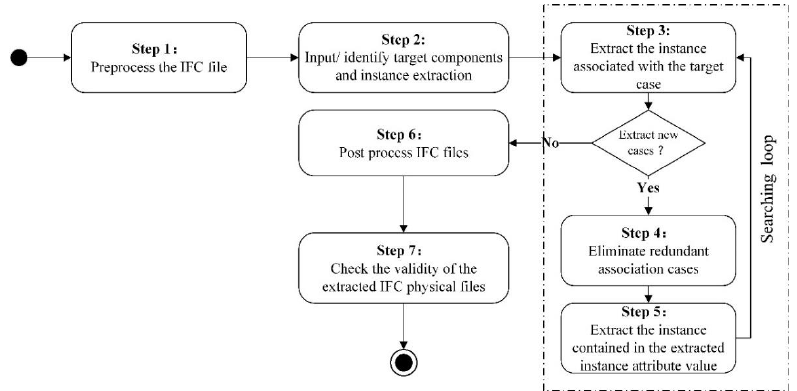
Figure 2. Component extraction based on the industry foundation classes (IFC) physical file.